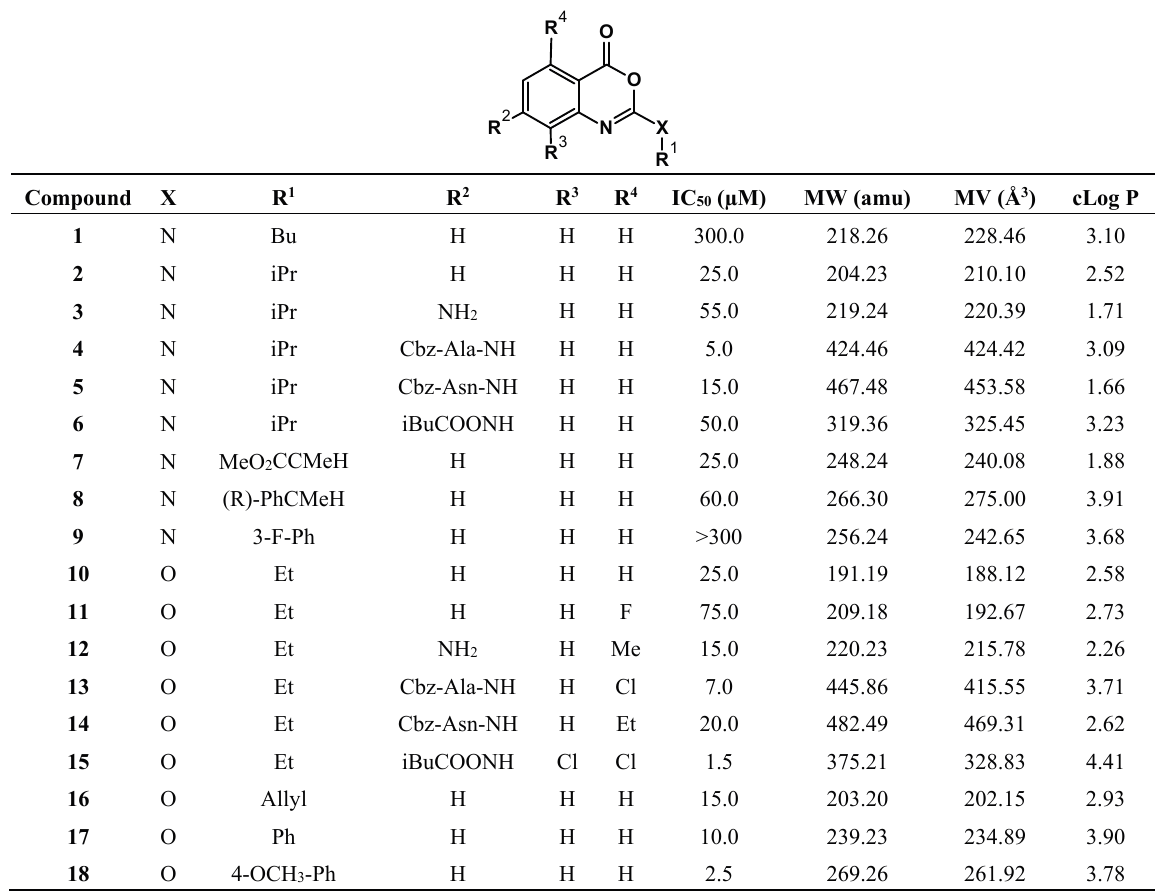
Table 1. Comparison between in vitro activity of benzoxazinones 1 – 18 and the theoretical calculated parameters including Molecular Weight (MW), Molecular Volume (MV) and lipophilicity (cLog P).